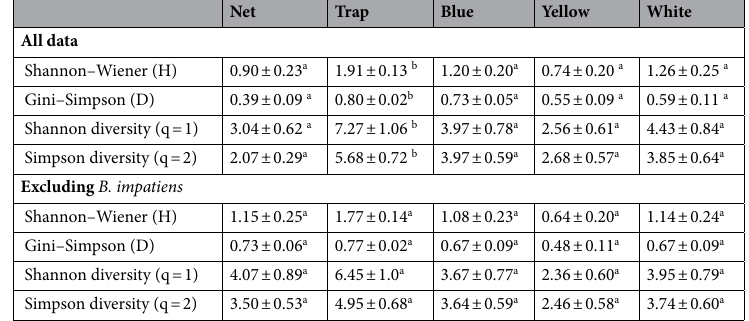
pan traps and least for yellow pan traps (Fig. 1b, q = 1 and 2). When comparing pan traps of different colors, the 95% confidence intervals overlapped for all three diversity measures (Fig. 1b). Daily diversity measures. Species richness. The two survey methods collected similar average number of bee species each day (F 1,18 = 0.61, P = 0.44), with (Mean ± SEM) 6.8 ± 1.7 bee species captured via netting and 8.7 ± 1.5 via pan traps. Moreover, the average number of bee species caught each day did not differ among pan traps of different colors (F 2,27 = 1.45, P = 0.25). Blue pan traps captured a daily average of 3.8 ± 1.0 bee species relative to 2.4 ± 0.6 for yellow and 4.7 ± 1.5 for white pan traps. Similar results were obtained when B. impatiens was removed prior to the calculation of the diversity measures. Without B. impatiens , 5.8 ± 1.8 bee species were captured via netting and 7.9 ± 1.6 via pan traps (F 1,18 = 0.76, p = 0.39). Pan traps of different colors caught similar average number of bee species each day (F 2,27 = 1.09, P = 0.35), with a daily average of 3.5 ± 1.0 bee species in blue, 2.2 ± 0.6 in yellow and 4.1 ± 1.1 in white pan traps.